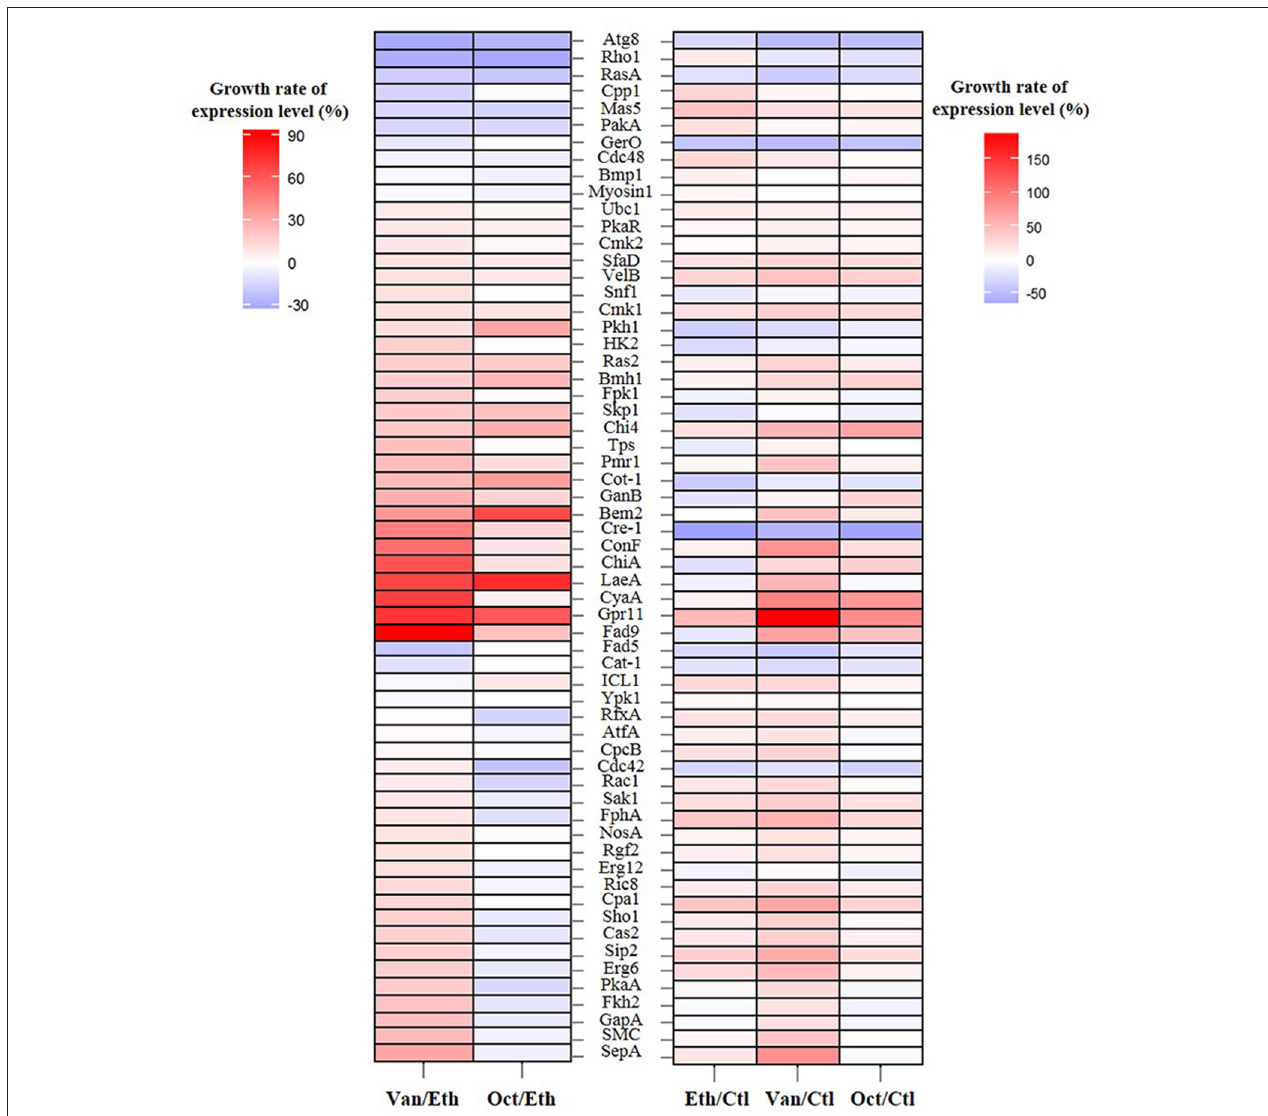
FIGURE 2 | Growth rate of the expression levels of 61 germination-related proteins in A. camphorata arthroconidia by iTRAQ-based proteomic analysis. Growth rate of the expression level of specific gene was calculated according to the following equation: [(% expression level of gene in compound-treated group/% expression level in control (or ethanol-treated) group) − 1] × 100. Ctl, control group of non-germinated arthroconida; Eth, ethanol-treated arthroconidia after 24h of incubation; Van, vanillin-treated arthroconidia after 24h of incubation; Oct, 1-octen-3-ol-treated arthroconidia after 24h of